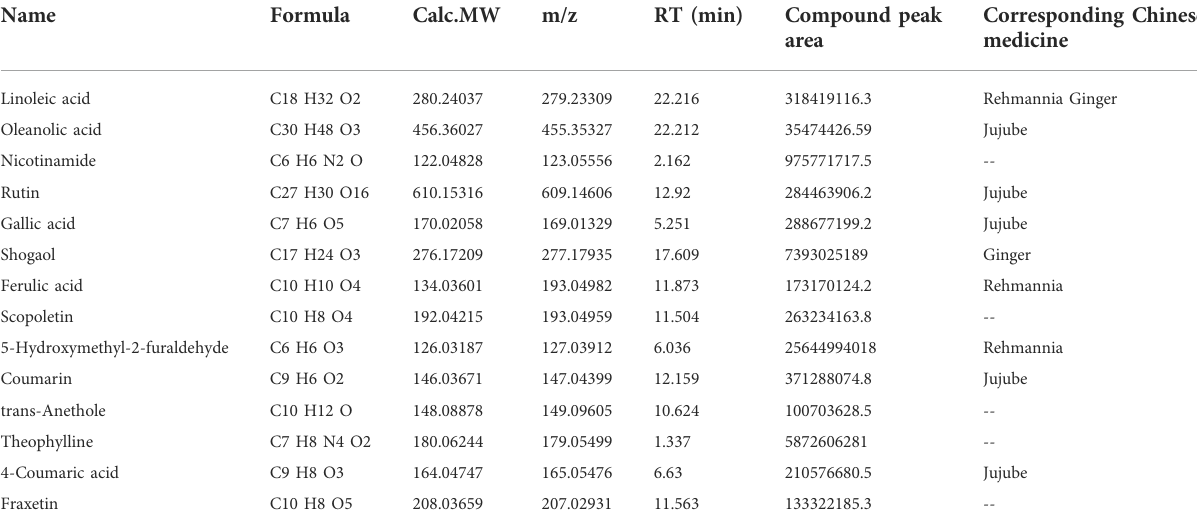
TABLE 3 | Information on the fourteen chemical constituents of